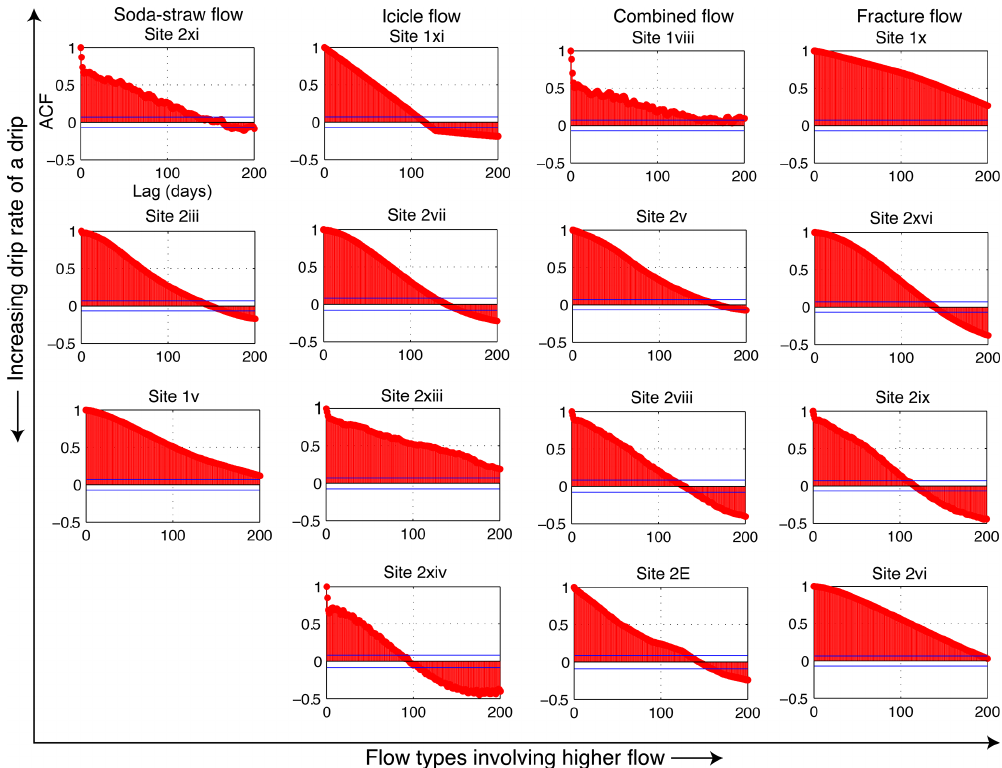
Figure 4. Autocorrelation functions of both chambers’ drip data according to flow classification of Mahmud et al. (2016). x and y axes of individual plots represent the lag (in days) and ACF, respectively (the axes labels are shown in the first ACF plot). ACFs for all sites appear in Fig.